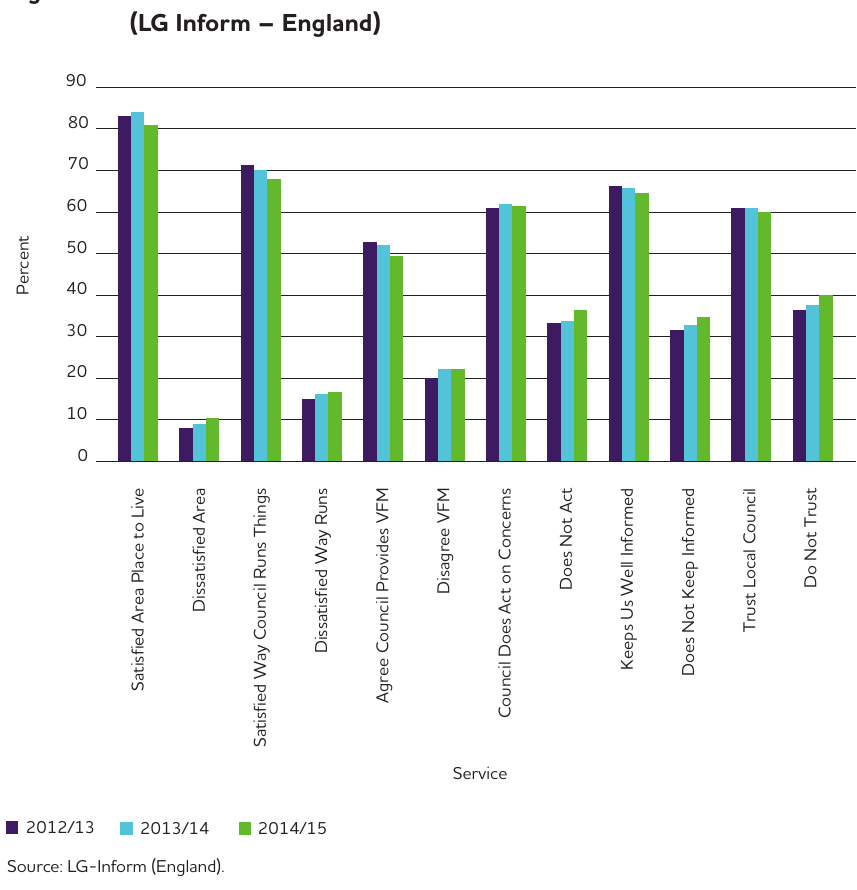
24 The cost of the cuts: the impact on local government and poorer communities